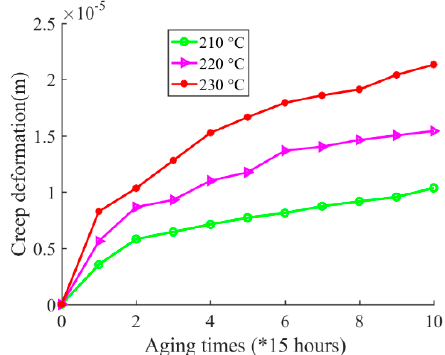
Figure 19. Inter-turn insulation creep deformation by calculation based on coil high-frequency parameter under 210 °C, 220 °C, and 230 °C.